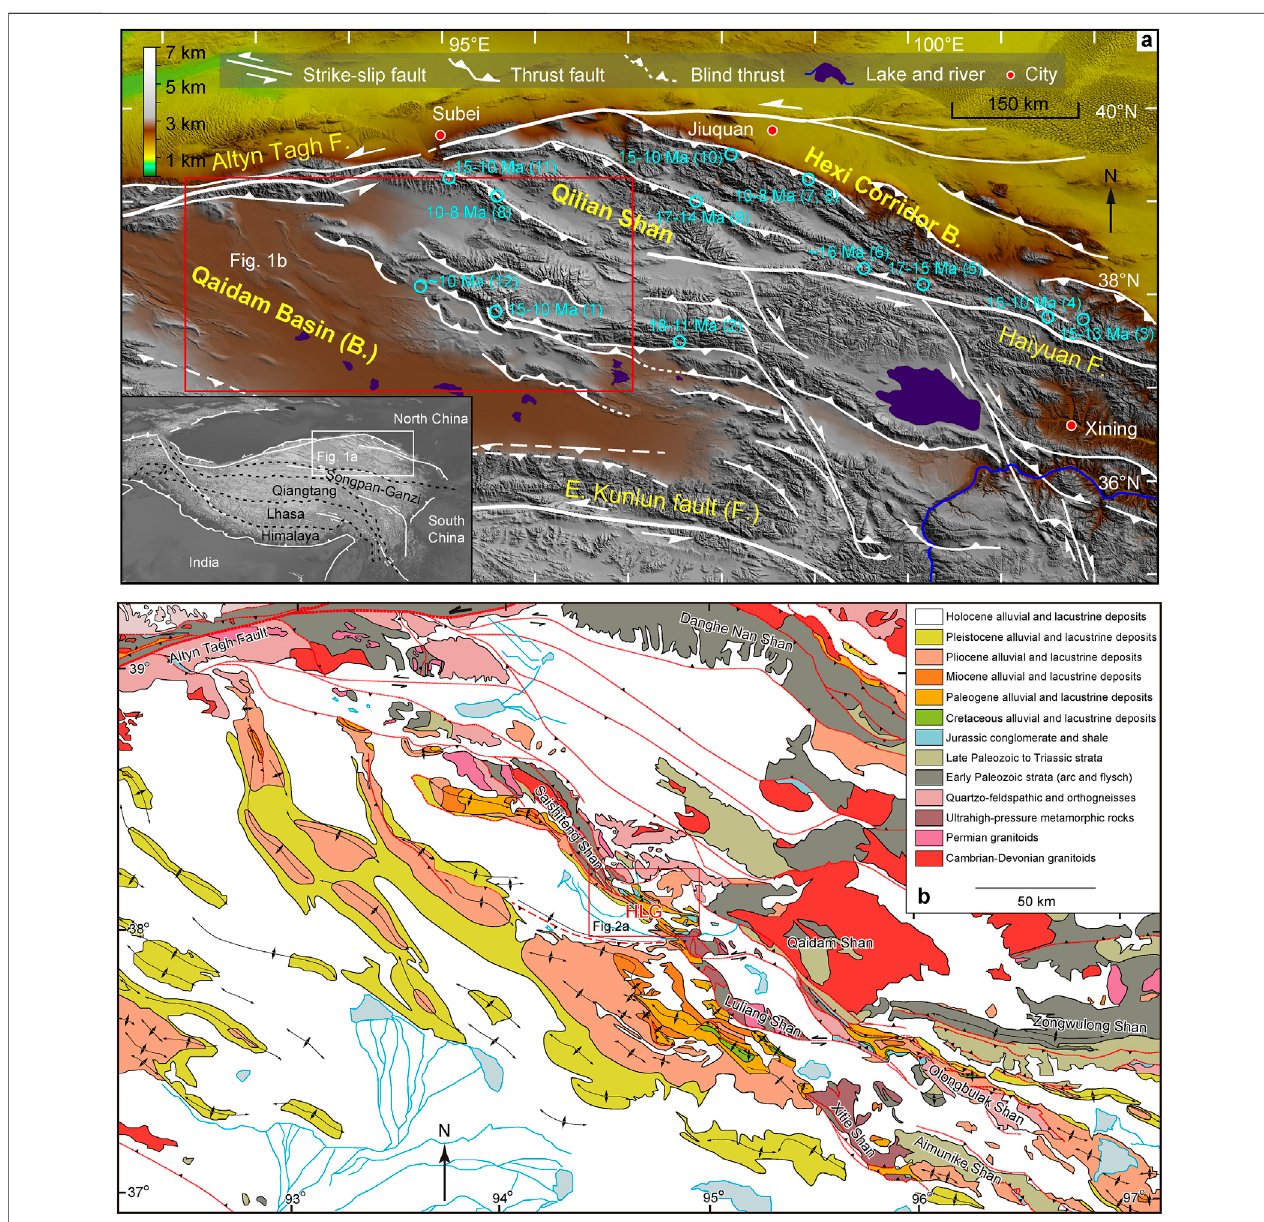
FIGURE 1 | Geologic setting of the study area. (A) Digital elevation model of the North Qaidam-Qilian Shan fold-thrust belt, showing the location, geomorphology, and tectonic framework. The ages and sites of published Miocene rapid exhumation events that from thermochronological data are present. The sources of these data are as follows: (1) Meng et al. (2020); (2) Pang et al. (2019a); (3) Wang et al. (2020); (4) Li et al. (2019); (5) Yu et al. (2019b); (6) Li et al. (2020); (7) Zheng et al. (2010); (8) Zhuang et al. (2018); (9) Zheng et al. (2017); (10) Pang et al. (2019b); (11) Yu et al. (2019a); and (12) this study. (B) Geologic map of the northern Qaidam Basin (modi fi ed from Yin et al., 2008), showing locations of the sampled section (Hongliugou, HLG).